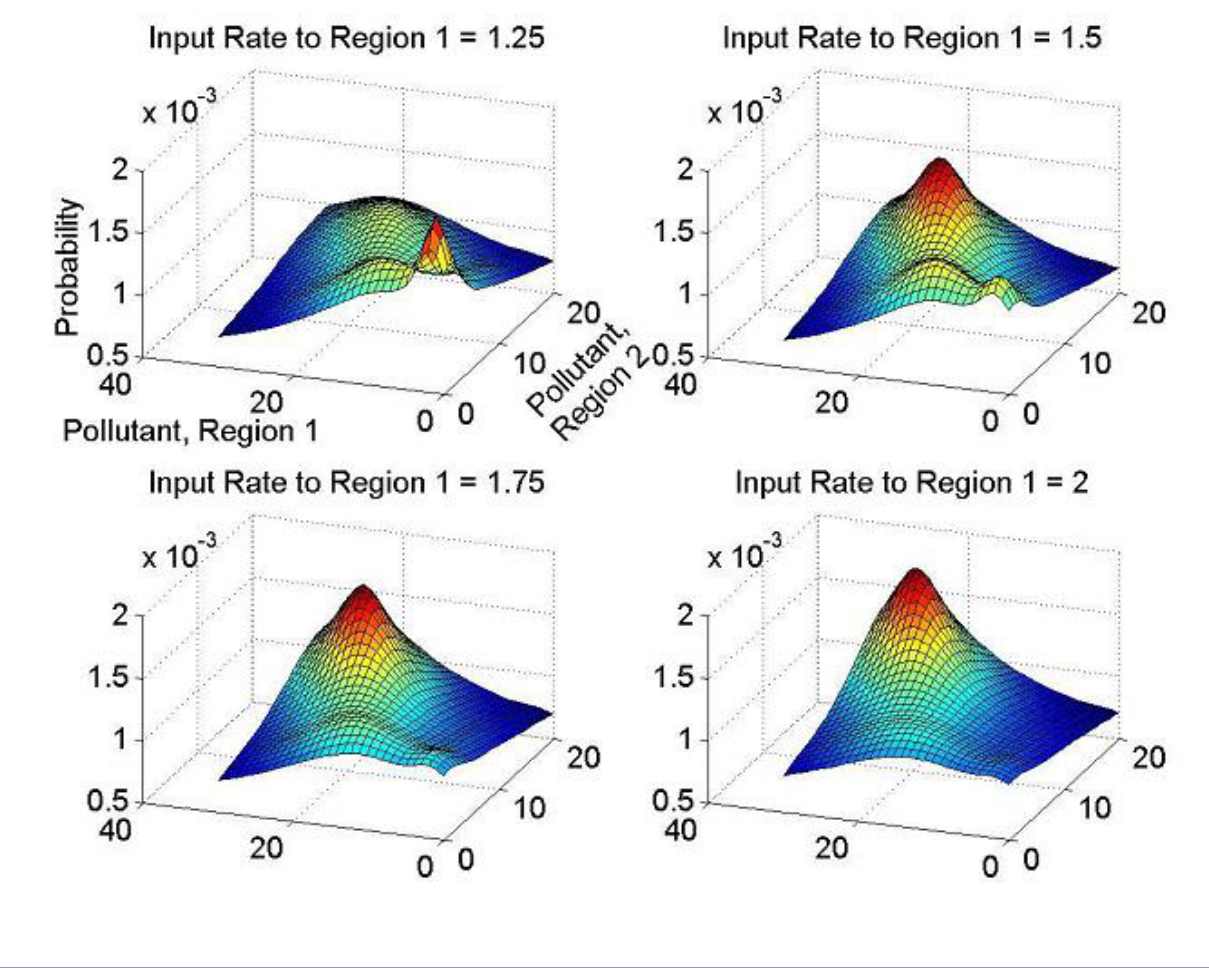
Fig. 5 . Stationary distribution vs. pollutant in region 1 and region 2 for four different input rates to region 1. Parameters: M (pollution discharge rate in region 1) = 1.25, 1.5, 1.75, and 2; M (pollution 1 2 discharge rate in region 2) = 0.75; c (decay rate in region 1) = 0.05; c (decay rate in region 2) = 0.1; D 1 2 (transport rate between regions) = 0.1; s (maximum sequestration rate) = 0.5; m (the pollutant level at which sequestration is half the maximum rate) = 5; q (which determines the slope of f(P) near P ) = 6. P stands for amount of pollutant, and f(P) scales the sequestration to the amount of